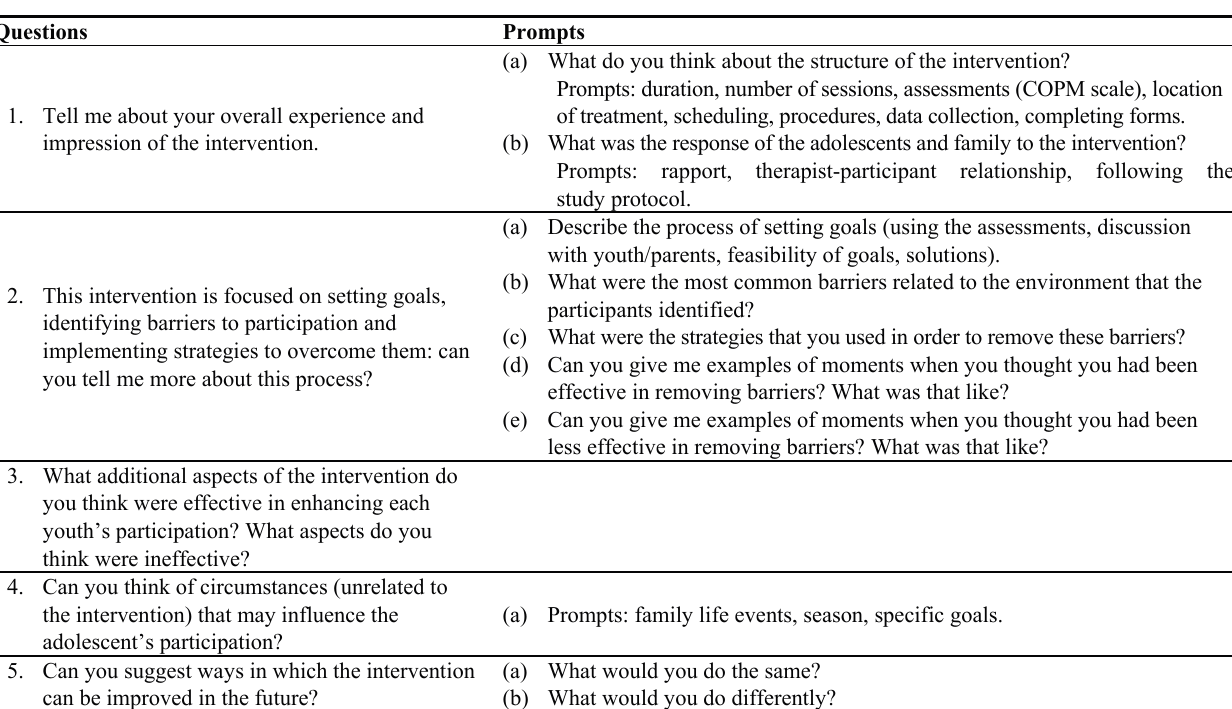
Table 1. Interview guide for